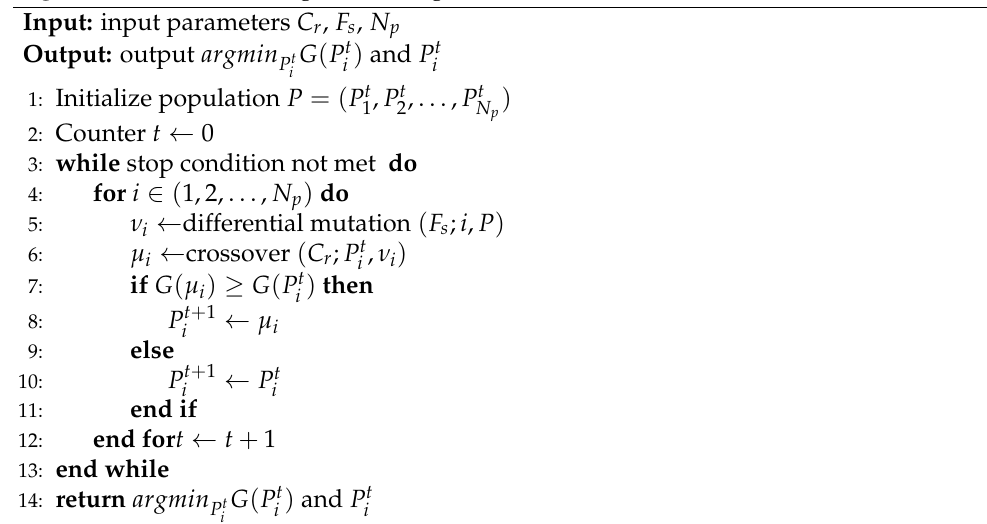
Algorithm 1 Anchor configurations algorithm based on